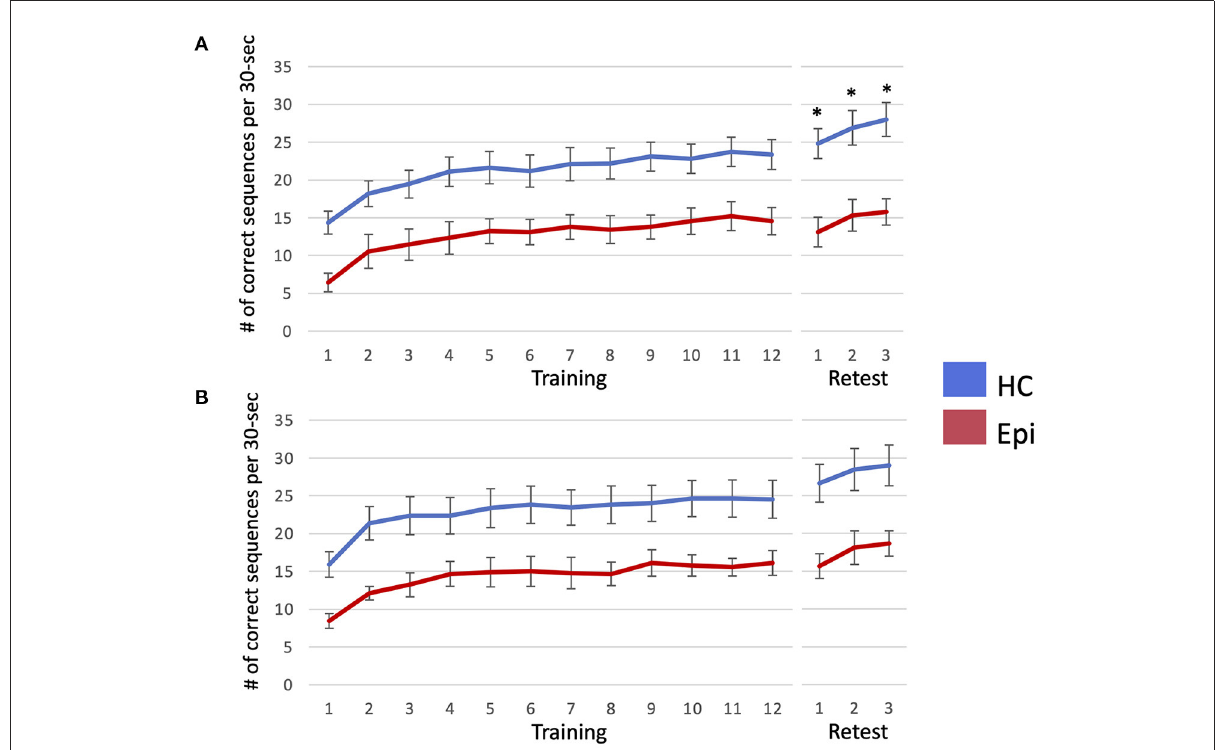
FIGURE3 The number of correctly-typed sequences is plotted per each block of Trial 1 (A) and Trial 2 (B) . Error bar indicates standard error. When the number of correctly-typed sequences were compared between the two groups using a linear mixed model for each trial, that of the healthy control group was significantly higher than that of the epilepsy patient group in all blocks of the retest session in Trial 1, as marked by asterisks. HC, healthy controls; Epi, patients with epilepsy.